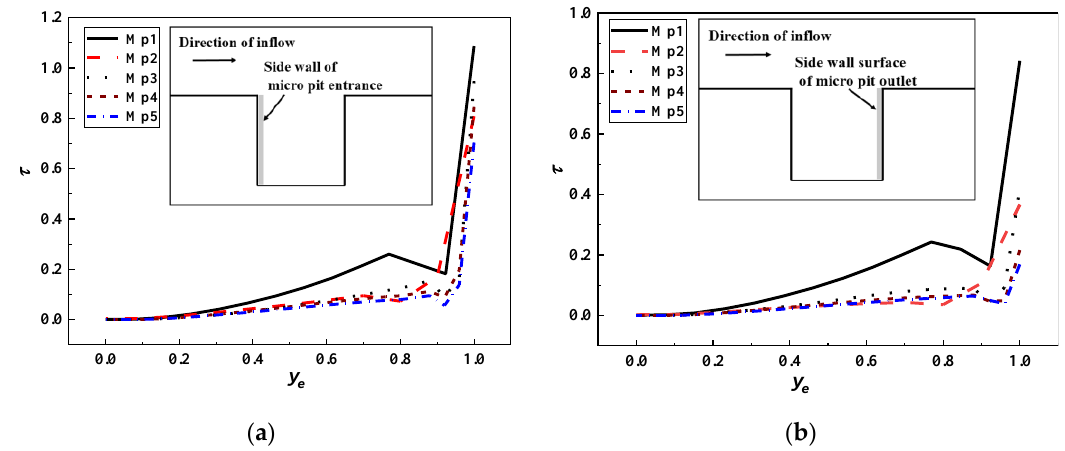
Figure 12. Shear stress distribution on the inner surface of the micropit: ( a ) Shear stress of the fluid inlet sidewall and ( b ) shear stress of the fluid outlet sidewall